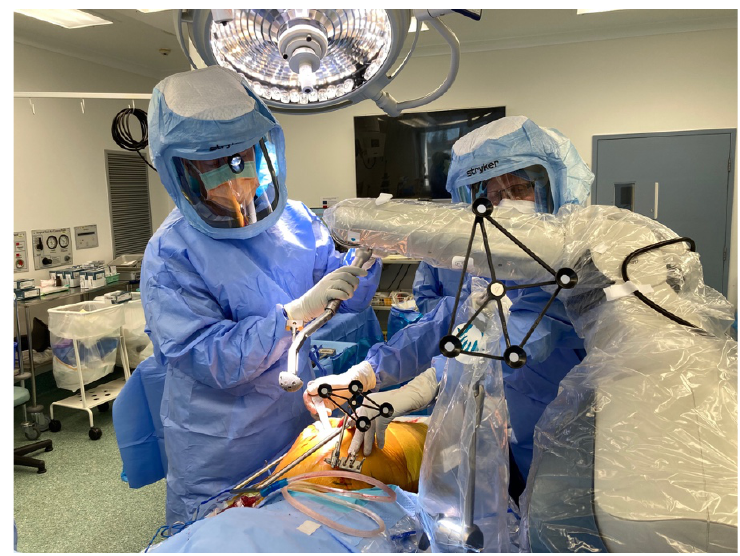
Figure 12. Insertion of cup using MAKO system.